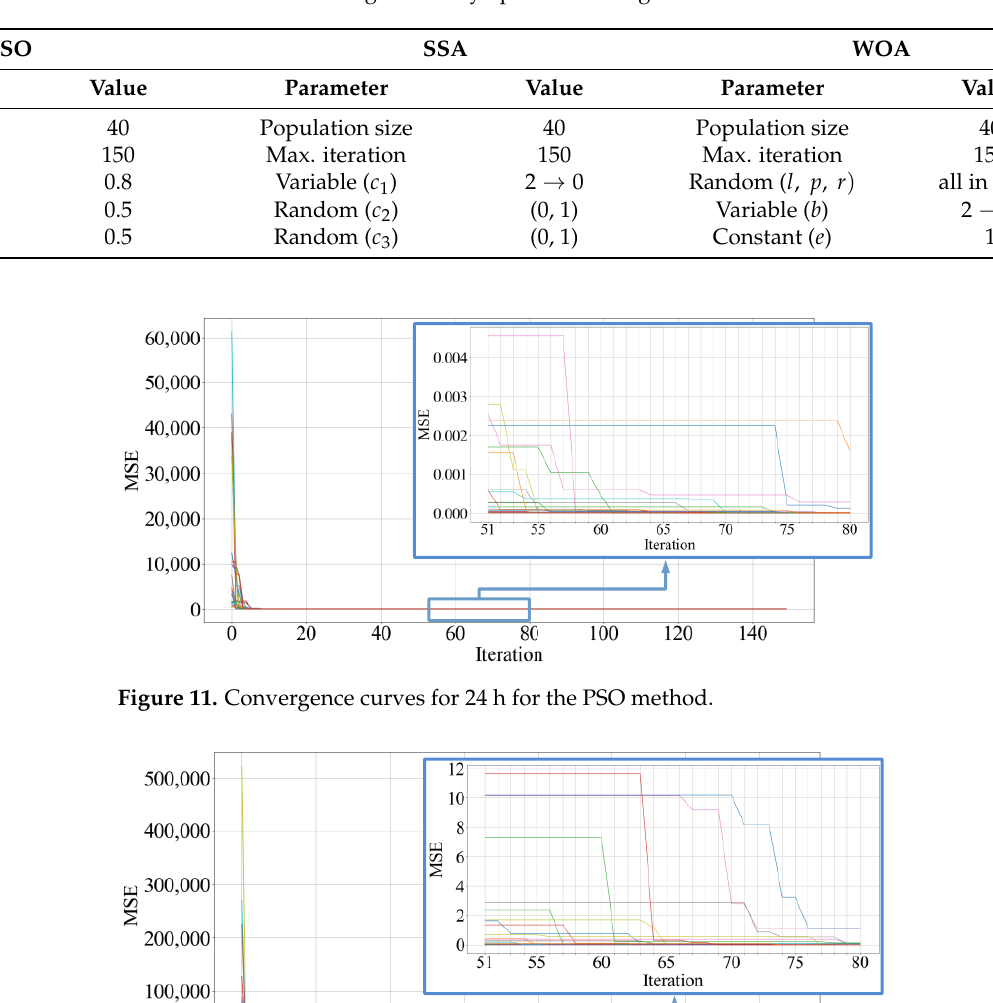
Table 6. Validation results (MRE%) for every single prediction model.